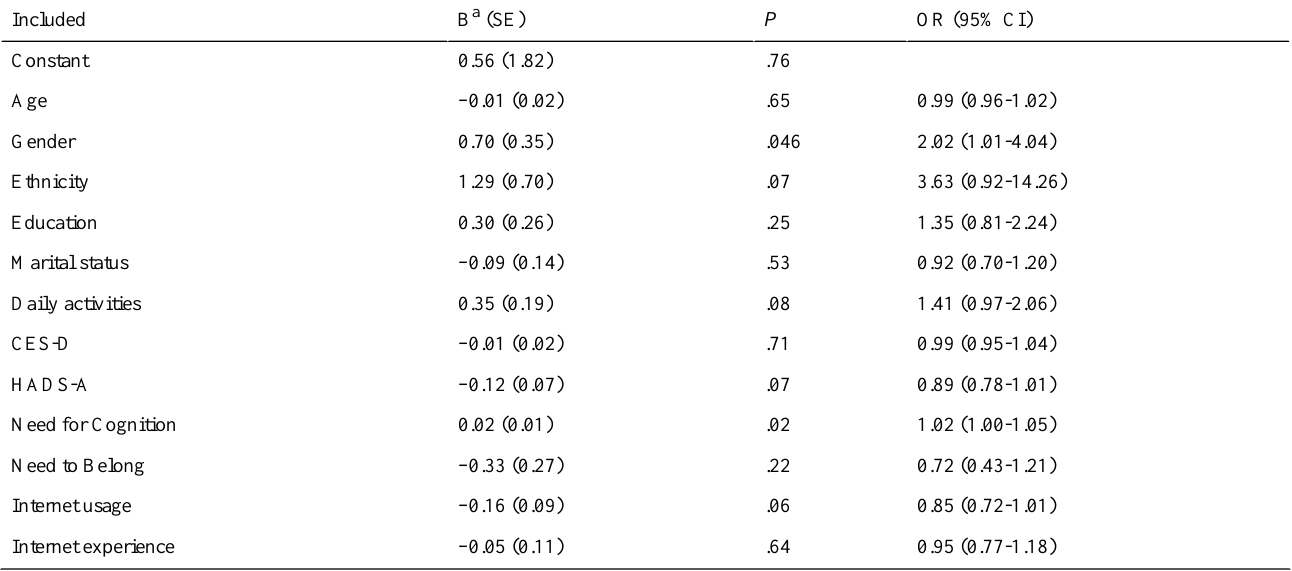
Table 2. Logistic regression baseline characteristics and